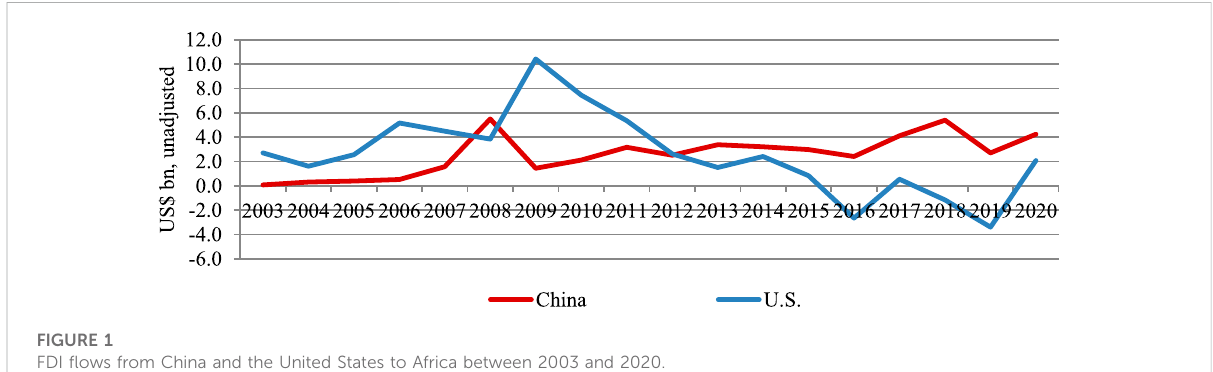
FIGURE 1 FDI fl ows from China and the United States to Africa between 2003 and